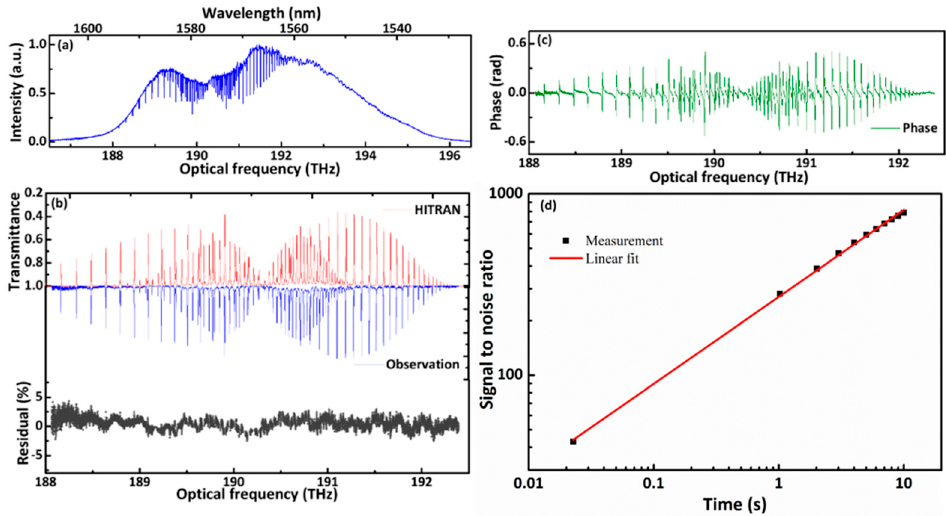
Figure 5. ( a ) Measured dual-comb spectrum data. ( a ) Entire spectrum from 186.5 to 196.5 THz (1526.7 to 1608.6 nm). ( b ) Normalized (blue) spectra, calculated (red) spectra, and the residual (gray) between them. ( c ) Normalized phase (green). ( d ) The evolution of the signal-to-noise ratio with measurement time.